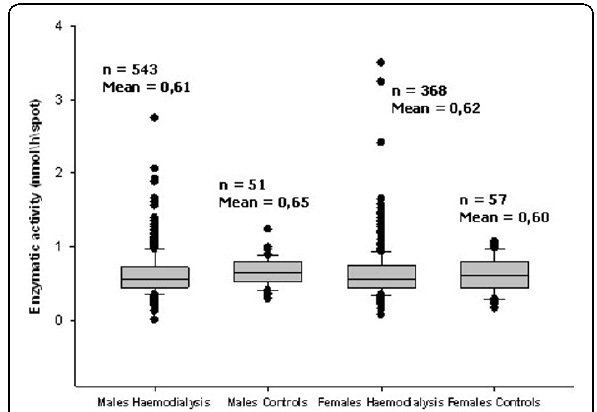
Figure 1 a -galactosidase A activity in control samples and in a haemodialysis population with both genders